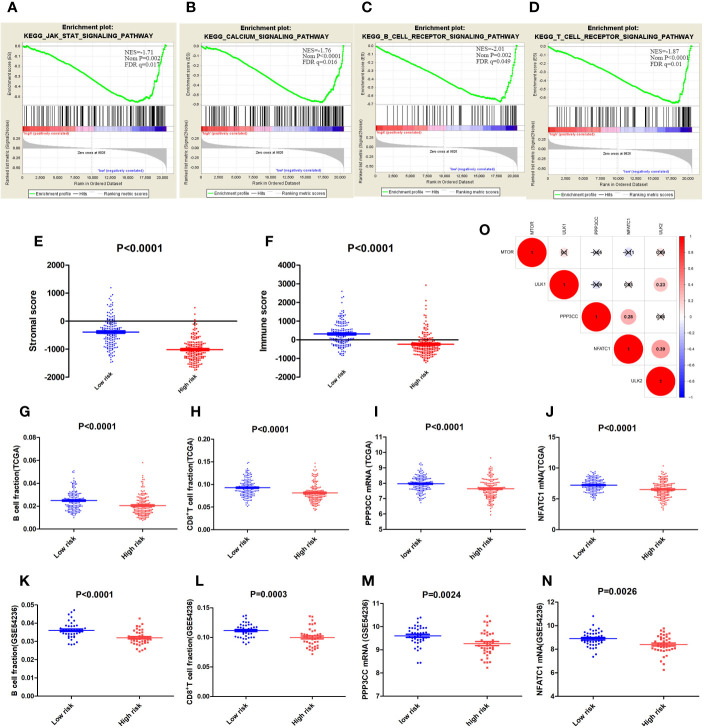

(A–D) The enriched immune-related Kyoto Encyclopedia of Genes and Genomes (KEGG) pathways. (E) Stromal and immune scores (F) in the low- and high-risk groups. B Cell fractions in the low- and high-risk groups in the TCGA (G) and GSE54236 (K) datasets; and CD8+ T cell fractions in TCGA (H) and GSE54236 (L) datasets. Expression of PPP3CC in the low- and high-risk groups in TCGA (I) and GSE54236 (M) datasets; and the expression of NFATC1 in the low- and high-risk groups in TCGA (J) and GSE54236 (N) datasets. (O) Correlation analysis among mTOR, ULK1, ULK2, PPP3CC, and NFATC1. “×” represents p > 0.001.